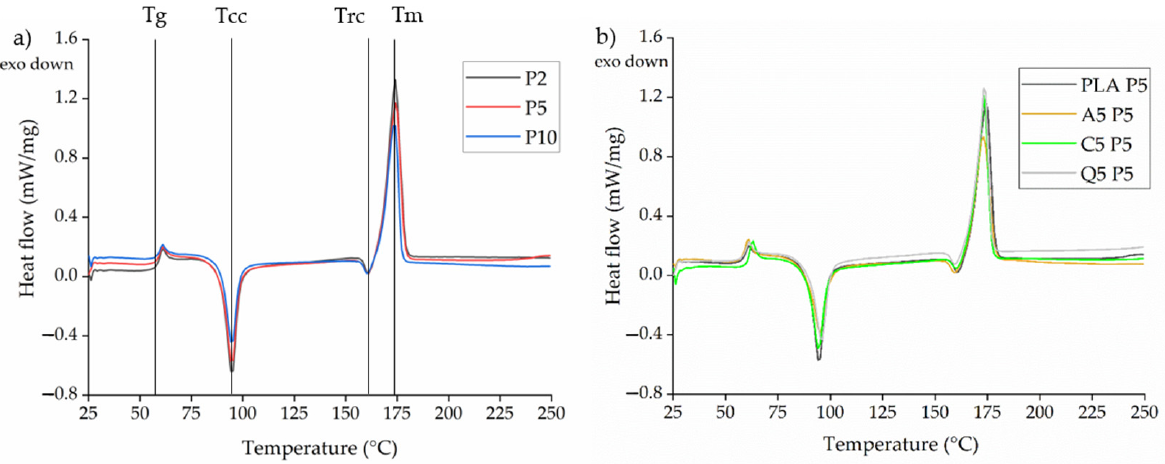
Figure 20. DSC thermograms of ( a ) PLA webs spun at different pump speeds (P2, P5, and P10 = 2, 5, and 10 rpm, respectively) and ( b ) PLA and PLA composite webs spun at a pump speed of 5 rpm (A5, C5, and Q5 = composites containing 5% ( w / w ) alizarin, curcumin, and quercetin, respectively). Table 5. T g , T cc , T m , and X c values of melt-electrospun fiber webs.